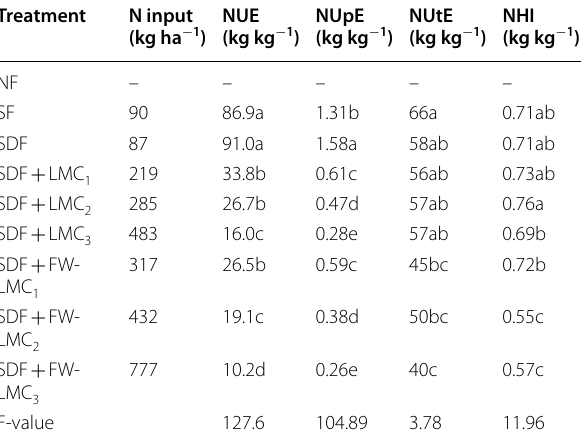
Table 6 Nitrogen use efficiencies (NUEs) of rice grown under different types and rates of fertilization at harvesting stage